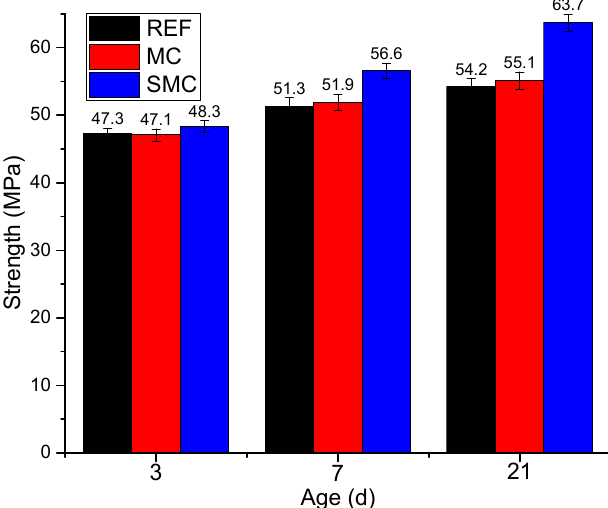
Figure 11. Strength variation of concrete with different proportions.